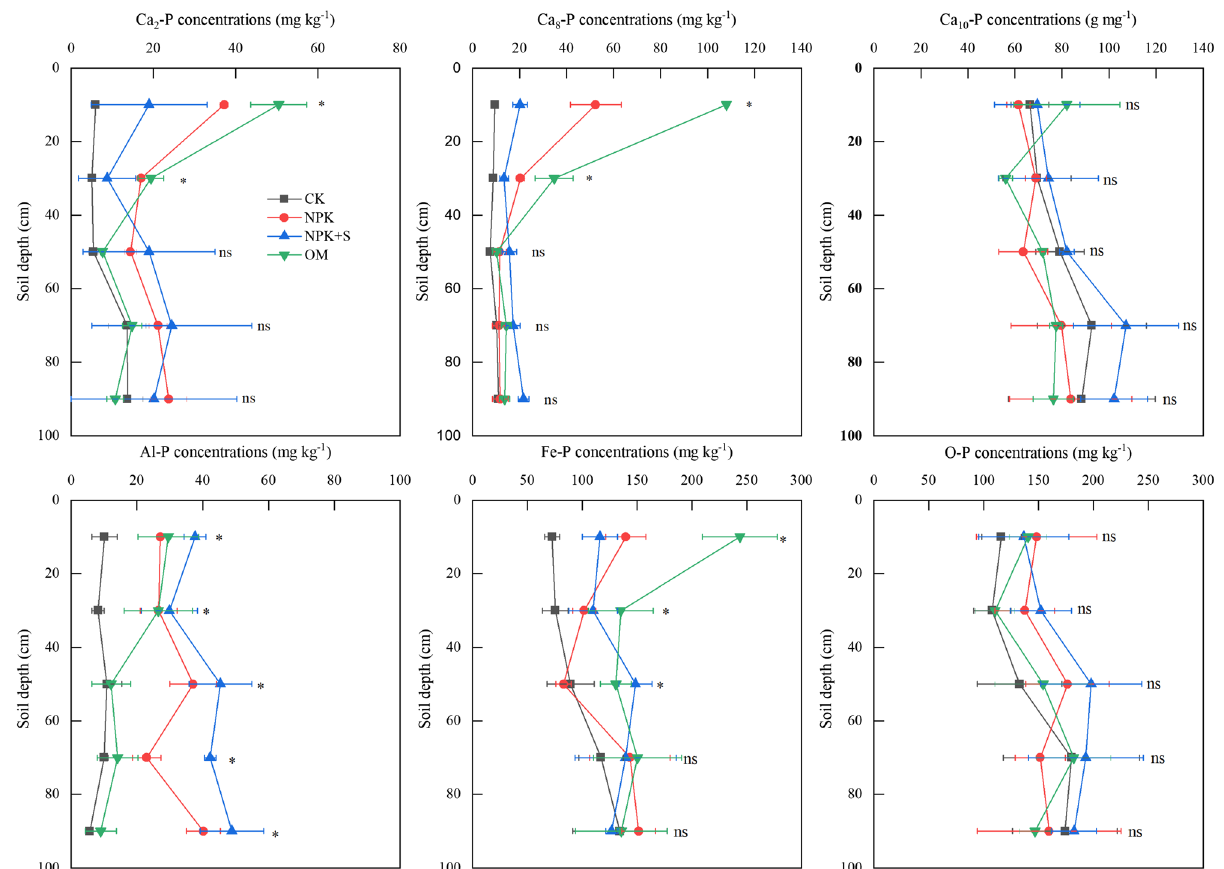
Figure 5. Effect of long-term application of chemical fertilizer, organic manure and straw on the distribution of inorganic P fractions. * indicates significant difference at P < 0.05 level at the same soil depth, ns indicates no significant difference regarding the Ca 2 -P, Ca 8 -P, Al-P, Fe-P, O-P and Ca 10 -P concentrations at the same soil depth. CK, no fertilizer application; NPK, chemical fertilizer application; NPK + S, chemical fertilizer plus maize straw incorporation; OM, organic manure